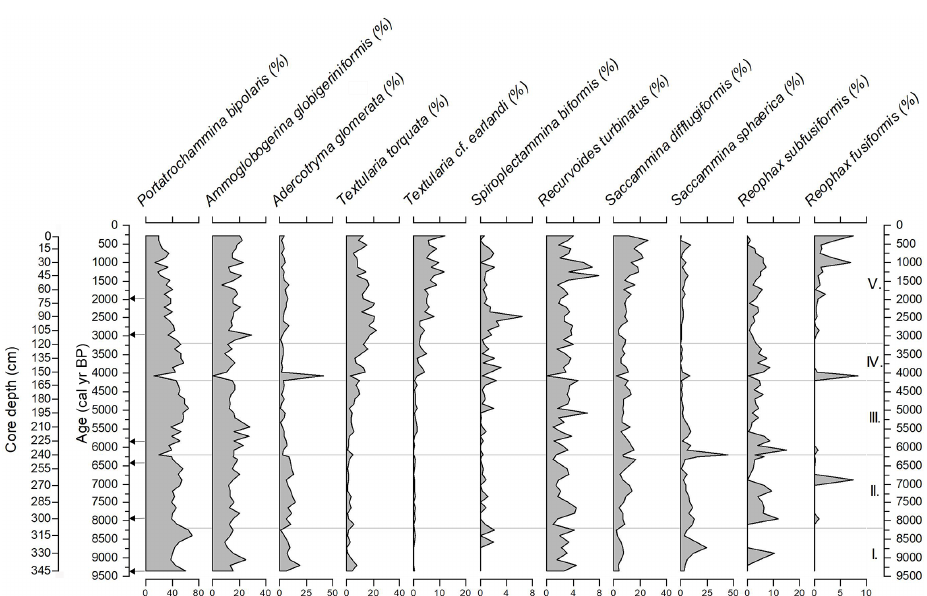
Figure A3. Relative abundances of the most abundant ( > 5% in at least one sample) agglutinated benthic foraminifera species (expressed as a percentage of total benthic agglutinated foraminiferal content) versus calibrated age along sediment core DA17-NG-ST07-73G. Ecozones (I–V) are shown on the right side of the figure. Black arrows next to the left primary y axis (age) mark radiocarbon dates. Note that the x axes have different